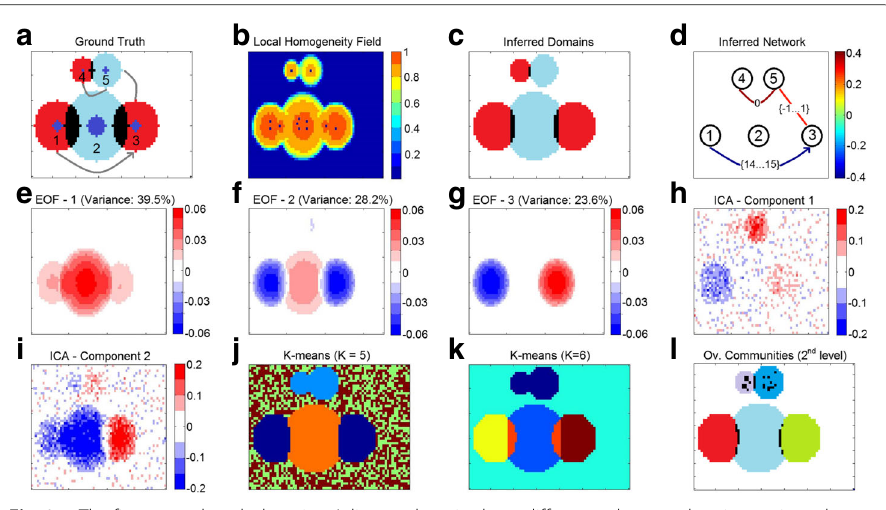
Fig. 2 a The five ground-truth domains. Adjacent domains have different colors, overlapping regions shown in black, and the core of each domain is in blue. The three constructed edges are shown in gray lines. b The homogeneity field ˆ r K ( i ) at each cell. The identified seeds are shown in blue. c The inferred domains: adjacent domains have different colors and overlaps are shown in black. d The inferred domain-level network: the color map refers to the edge correlation. The lag associated with each edge is also shown. e, f, g The first three EOF (PCA) components. The variance explained by each component is shown at the top of each figure. h, i The two ICA components. j, k K-means clustering. l The second hierarchical level of community structure as identified by OSLOM: each community has a distinct color and overlaps are shown in